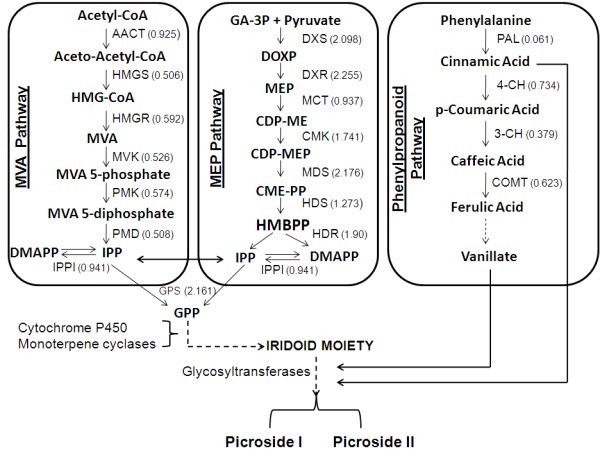
Picrosides biosynthetic pathway in P. kurrooa (adapted from Kawoosa et al. and Dixon and Paiva [5,59]). Picrosides are iridoid glycosides derived from cyclization of geranyl pyrophosphate (GPP) to iridoid moiety. Glucose and cinnamate/vanillate convert iridoid into picroside I and picroside II. These steps involve series of hydroxylation and glycosylation reactions catalyzed by cytochrome P450 and glycosyltransferases. GPP can be derived from mevalonate (MVA) or 2-C-methyl-D-erythritol 4-phosphate (MEP) pathway. Enzymes of MVA pathway are as follows: AACT, acetyl-CoA acetyltransferase; HMGS, 3-hydroxy-3-methylglutaryl-CoA synthase; HMGR, 3-hydroxy-3-methylglutaryl-coenzyme A reductase; MVK, mevalonate kinase; PMK, phosphomevalonate kinase; PMD, diphosphomevalonate decarboxylase. Enzymes of MEP pathway are DXS, 1-deoxy-D-xylulose-5-phosphate synthase; DXR, 1-deoxy-D-xylulose-5-phosphate reductoisomerase; MCT, 2-C-methyl-D-erythritol 4-phosphate cytidylyltransferase; CMK, 4-diphosphocytidyl-2-C-methyl-D-erythritol kinase; MDS, 2-C-methyl-D-erythritol 2,4-cyclodiphosphate synthase; HDS, 4-hydroxy-3-methylbut-2-enyl diphosphate synthase; HDR, 4-hydroxy-3-methylbut-2-enyl diphosphate reductase. Isopentenyl pyrophosphate isomerase (IPPI) catalyzes the isomerisation of dimethylallyl pyrophosphate (DMAPP) to IPP whereas conversion of IPP to geranyl pyrophosphate (GPP) is catalyzed by geranyl pyrophosphate synthase (GPS). Enzyme of phenylpropanoid pathway involved in biosynthesis of cinnamate are PAL, phenylalanine ammonia-lyase; 4-CH, cinnamic acid 4-hydroxylase; 3-CH, p-coumarate 3-hydroxylase; COMT, caffeoyl-CoA 3-O methyltransferase. Solid arrows indicate known steps, whereas broken arrows represent unknown intermediates and enzymes. Numerals in parenthesis indicate fold change in gene expression at 15°C as compared to 25°C based on reads per exon kilobase per million (RPKM) values (detailed RPKM values are shown in Figure 8 and Additional file 13).